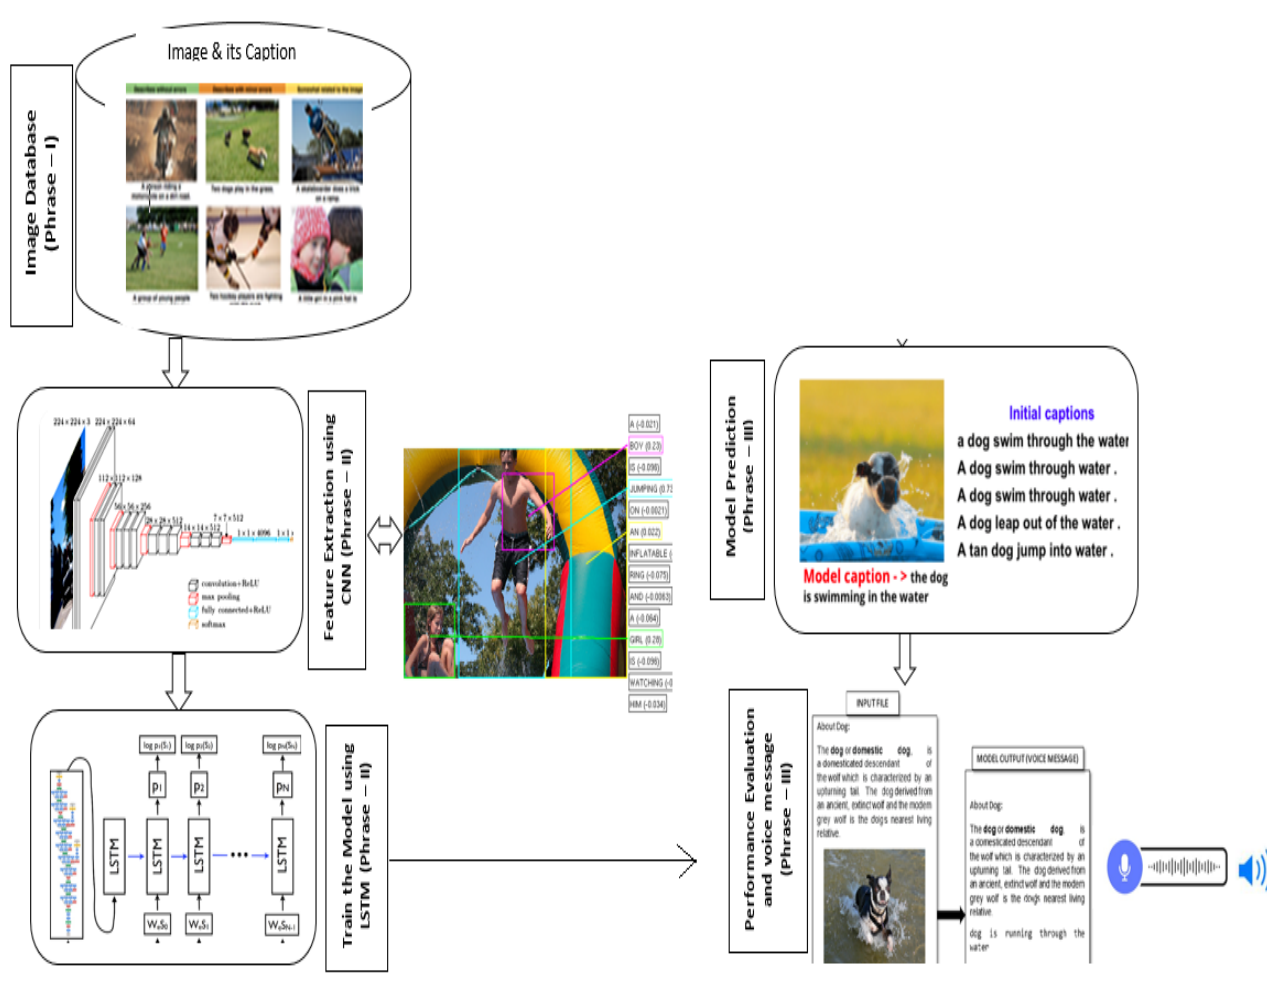
Figure 1. The Deep Learning Reader